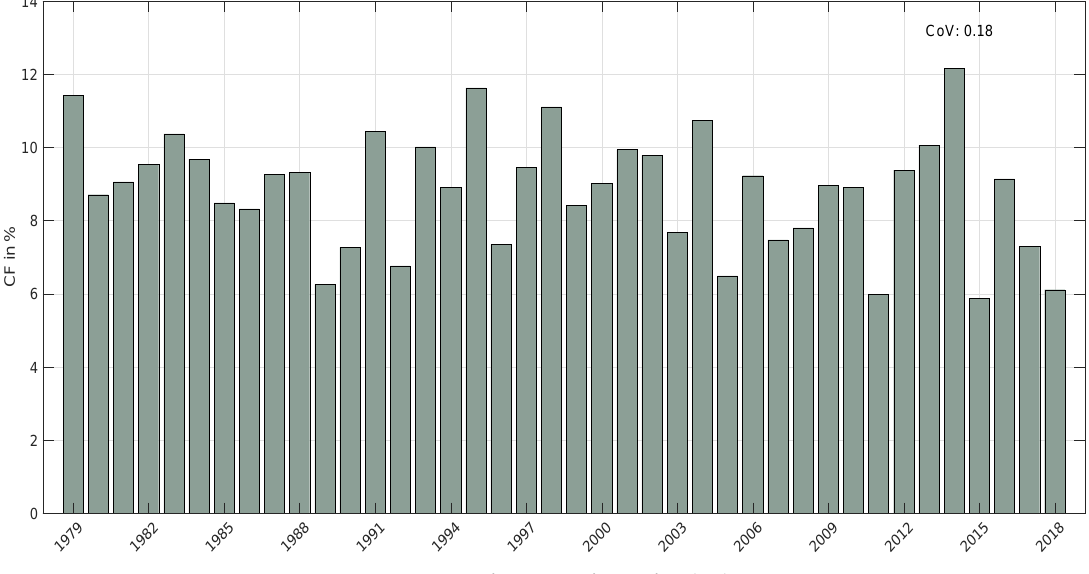
Figure 4. Variation of capacity factor for the location.